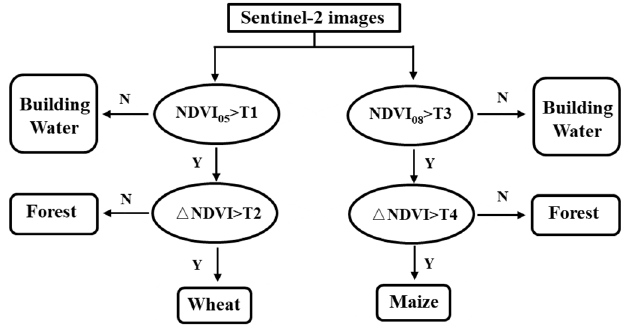
Figure 7. Decision tree for crop classification on the North China Plain. T1-4 represent the threshold values of each procedure with slight differences among the subregions.